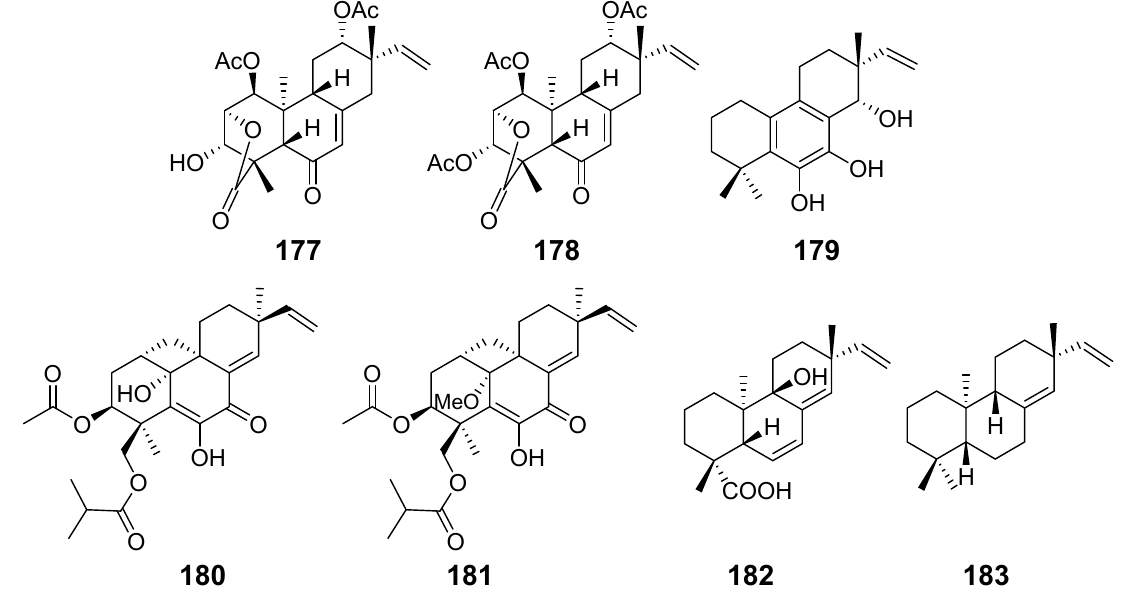
Figure 18. Structures of compounds 177 – 183 .